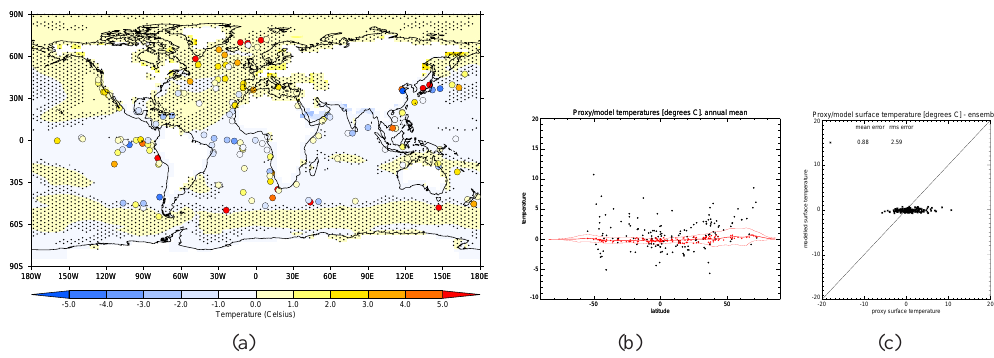
Fig. 9. (a) Simulated annual mean SST change, LIG minus pre-industrial, for the model ensemble. Stippled regions show area where less than 70% of the model simulations agree on the sign of the temperature change. Also shown are the ocean data points of Turney and Jones (2010). (b, c) Comparison of annual mean SSTs with data from Turney and Jones (2010). (b) Latitudinal distribution of data (black dots), compared with the ensemble mean model (red dots, from the same locations as the proxy data), with the zonal model ensemble mean (thick red line), and ± 1 standard deviation of the zonal model ensemble mean (thin red lines). (c) Modelled ensemble mean temperature vs. proxy data temperature for each marine site in the Turney and Jones (2010) dataset. All units are ◦ C.